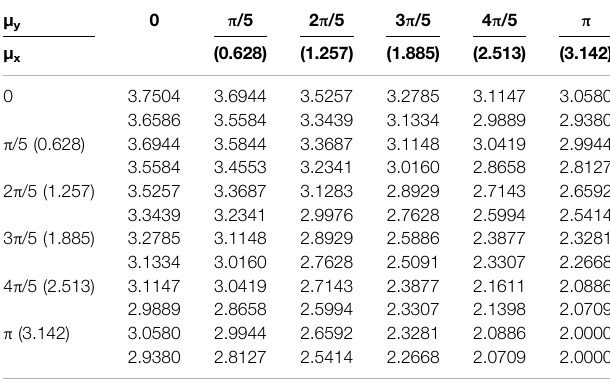
TABLE 1 | Nondimensional frequencies ( Ω ) for a periodic plate (orthogonal line- supported) with the square element. μ